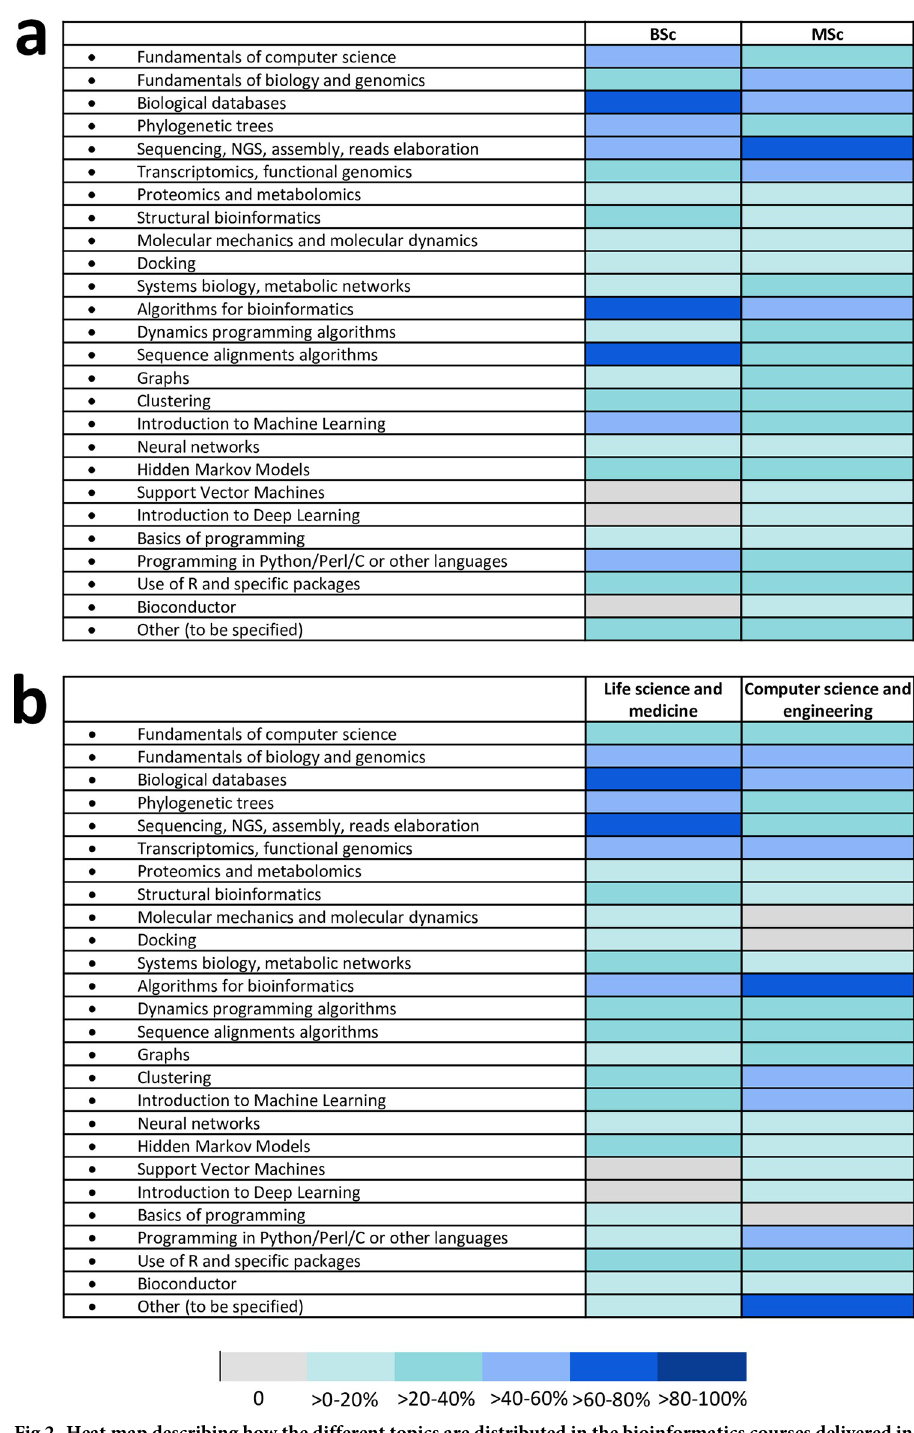
Fig 2. Heat map describing how the different topics are distributed in the bioinformatics courses delivered in different degrees levels (panel (a)) or in study paths belonging to different scientific areas (panel (b)). Different colors refer to the different percentages of occurrence of each topic in the bioinformatics